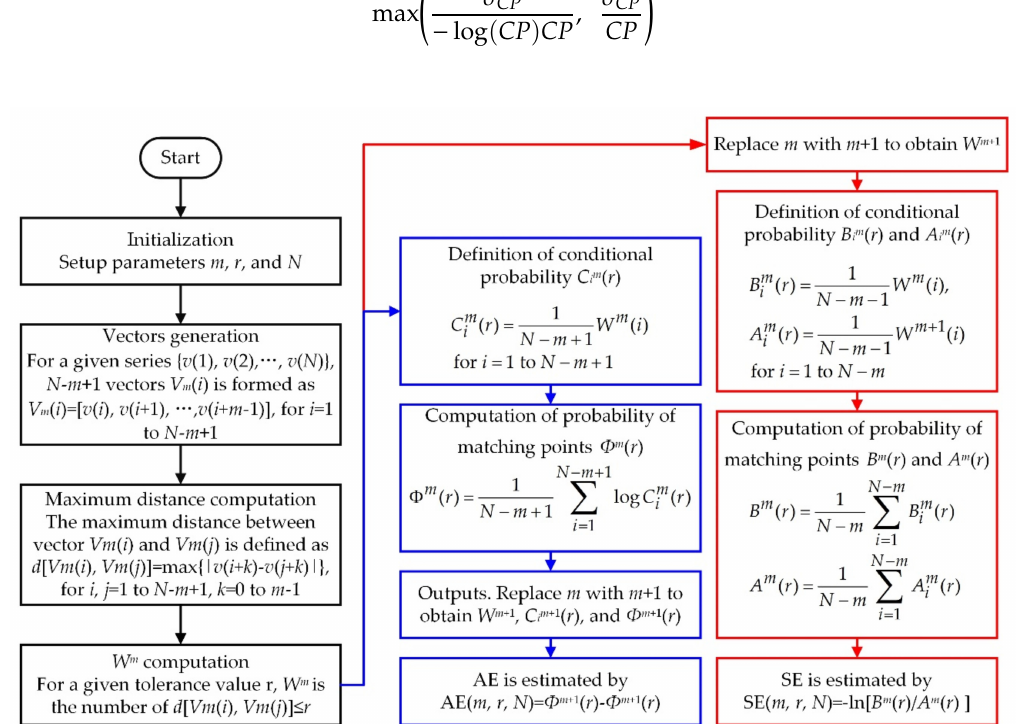
Figure 5. Flowchart of the approximate entropy (blue) and the sample entropy (red) algorithm.